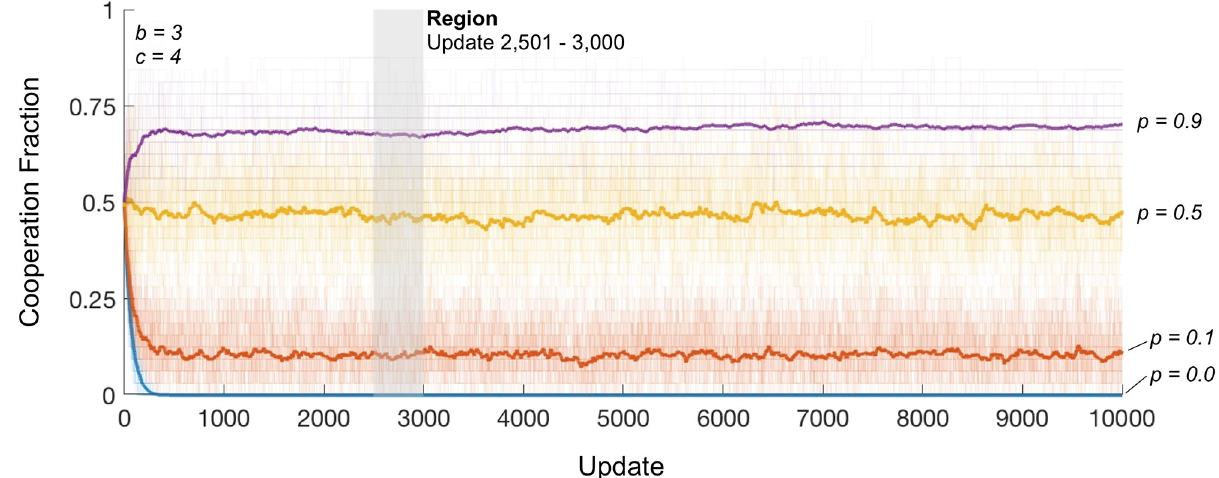
Fig 3. Cooperation under collaboration in the long run. Average share of cooperation in the population (thick lines) under different collaboration parameter values, p, as indicated, over 50 different random-graphs having e = 0.10 and benchmark conditions. Coloured, faint lines show share of cooperation in the population from each run. Region indicated (grey transparency) corresponds to updates used to calculate average cooperation fraction for contour plots in Fig 2.